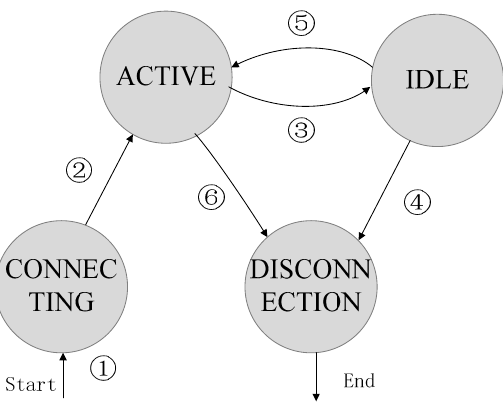
Figure 4. State transition. The switch can enter an appropriate state when the connection state